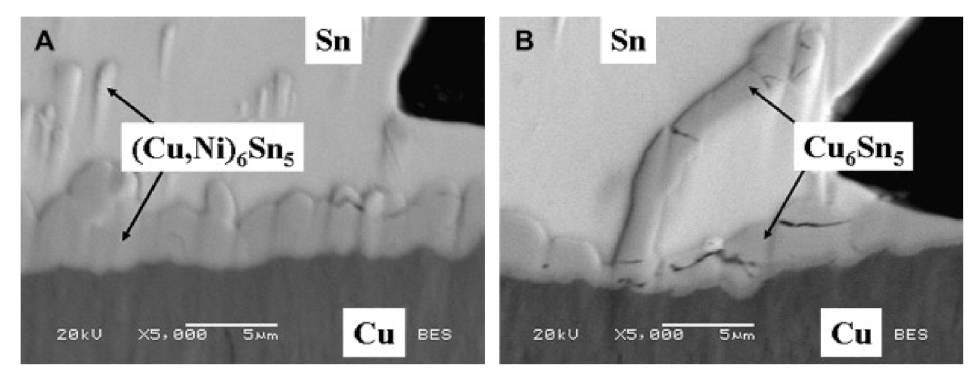
Figure 3. Typical cross-sectioned of solder joints; ( A ) Sn-0.7Cu-0.05Ni solder and ( B ) Sn-0.7Cu solder